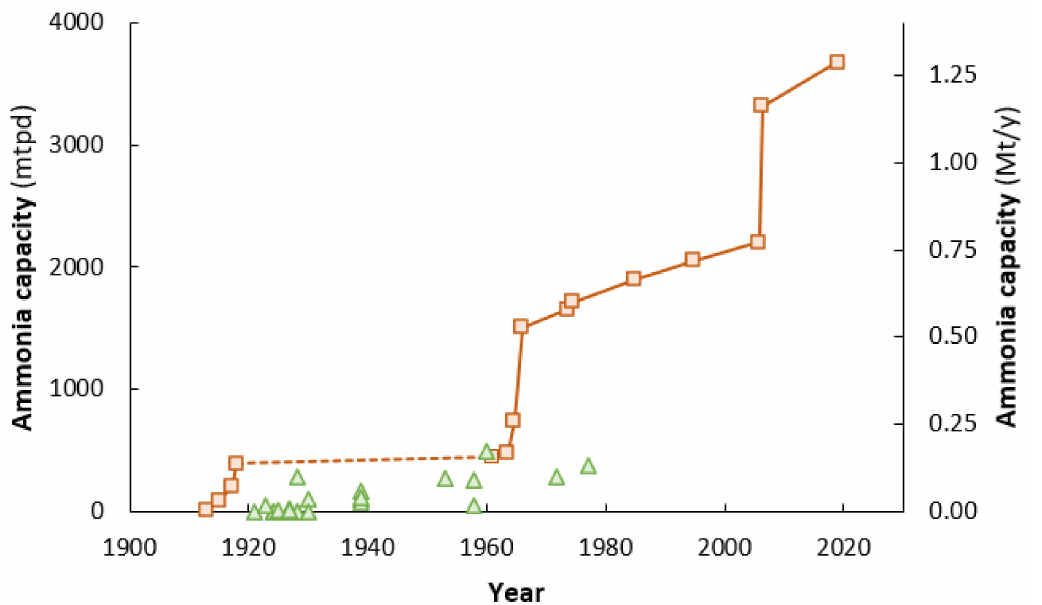
Figure 11. Ammonia production, individual unit capacities, through the years, fossil-based ammonia production (brown squares), and renewable ammonia production (green triangles). Estimates for the largest fossil-based ammonia units between 1913 and 1918 are from Travis [12], and between the mid-1960s and 2019 from Brightling [15] and ThyssenKrupp [56]. Estimates for renewable ammonia units are discussed in this